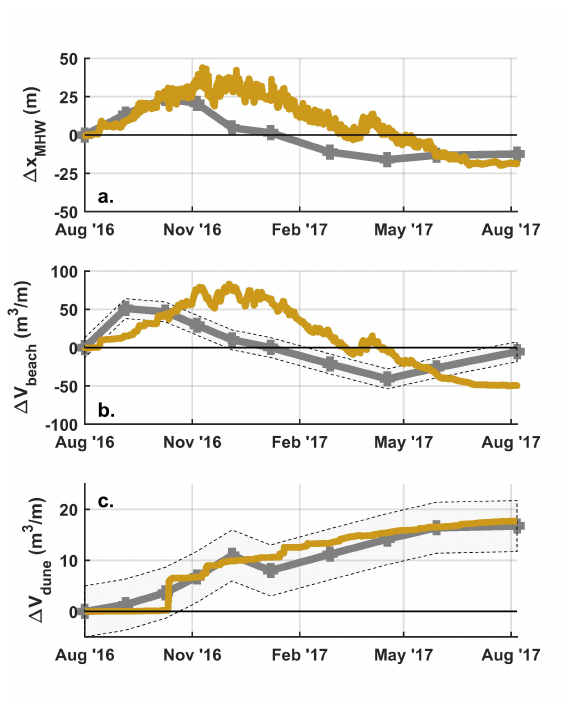
Figure 5. Measured (grey lines) versus calibrated model simulations (yellow lines) of ( a ) MHW shoreline change, ( b ) beach volume change, and ( c ) dune volume change. Error bars are added for the volumetric measurements assuming a ± 0.08 m vertical error for the topographic